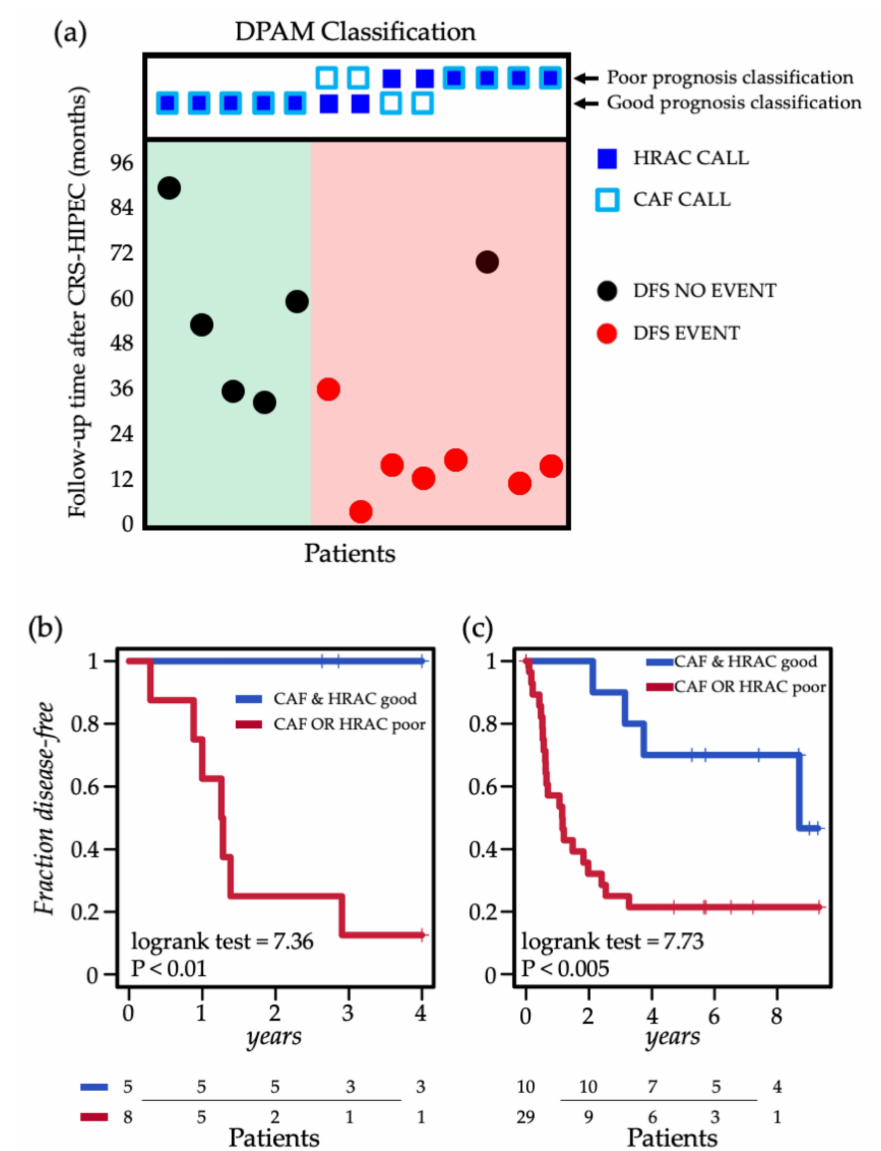
Figure 3. Combined prognostic performance of the HRAC and CAF scores. ( a ) Classification of the 13 DPAM cases according to CAF and HRAC scores on central samples with DFS annotation (y axis); samples are subdivided on the basis of HRAC and CAF calls (upper panel), and subdivided in 2 groups: CAF AND HRAC good (green background) and CAF OR HRAC poor (red background). ( b ) Kaplan–Meier plot of DFS of HRAC and CAF score integration in the 13 DPAM cases. ( c ) Kaplan–Meier plot of DFS of HRAC and CAF score integration in the GSE75535